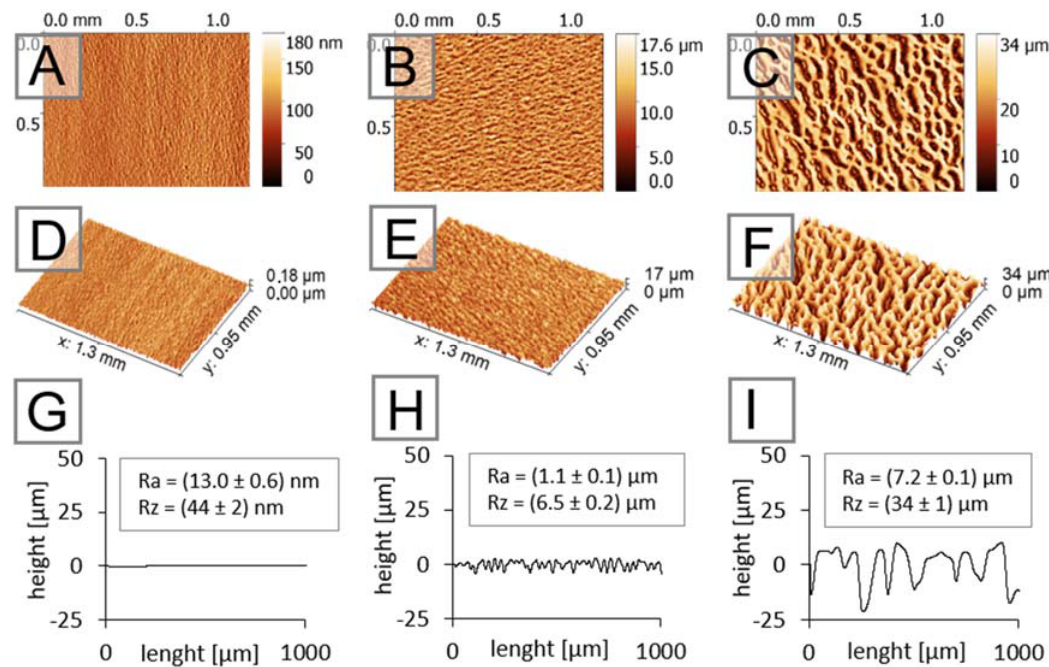
Figure 2. Optical profilometry of native ( A , D , G ), meso-structured ( B , E , H ), and macro-structured ( C , F , I ) substrates. While the native substrate has a roughness in terms of nanometers, the meso- and especially the macro-structured substrates demonstrate roughness in terms of micrometers.